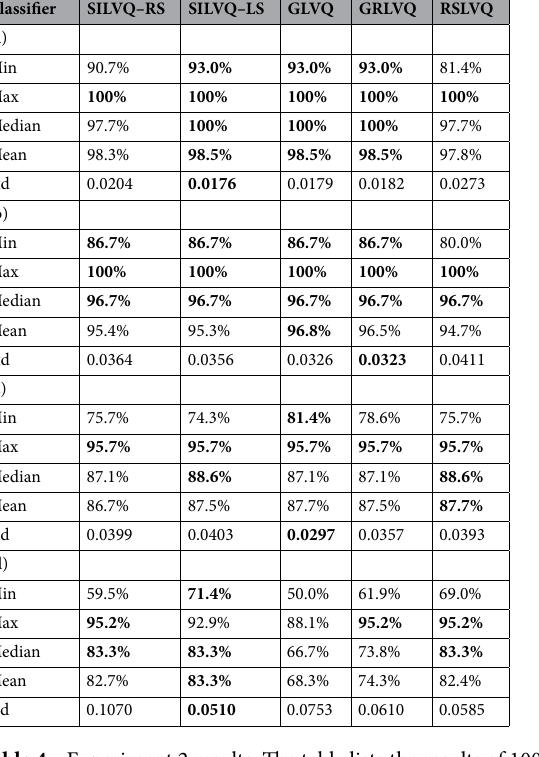
Table 4. Experiment 2 results. The table lists the results of 100 trials in which each model trained with each dataset 30 times. The values in the table include the minimum, maximum, median, mean, and standard deviation of accuracy. Best results for each dataset are in boldface. (a) Results for Glass dataset. (b) Results for Iris dataset. (c) Results for Ionosphere dataset. (d) Results for Sonar